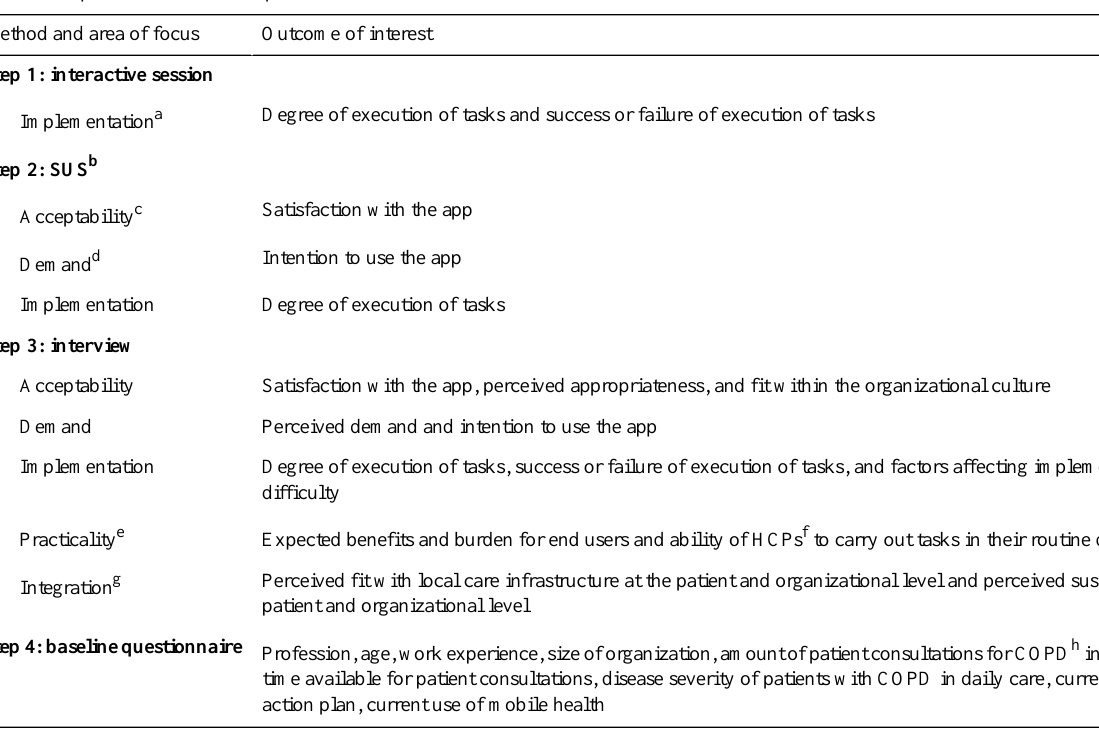
Table 1. Stepwise data collection procedure related to the areas of focus and outcomes of